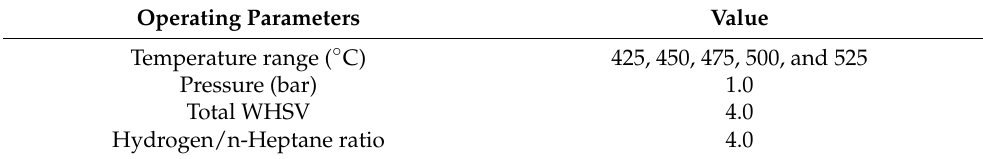
Table 2. Experimental operating conditions of the catalytic reforming